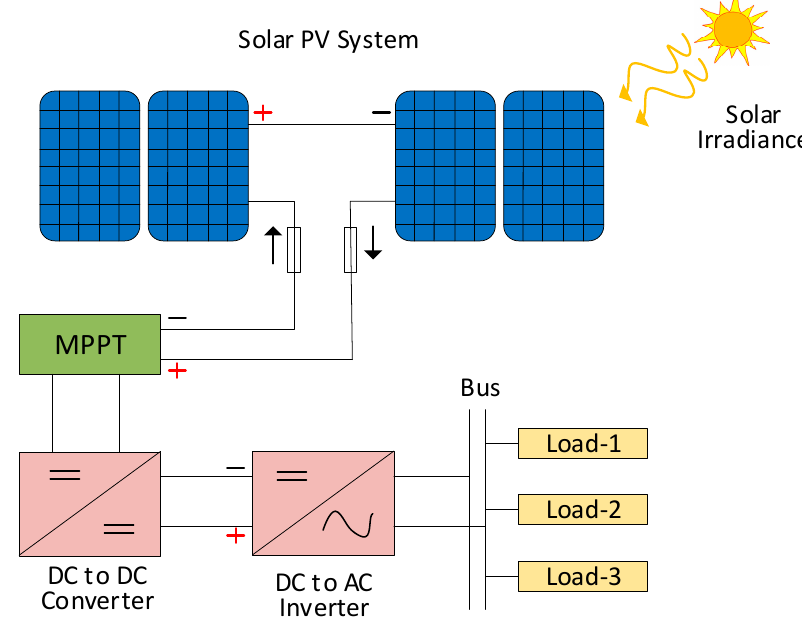
Figure 1. Solar photovoltaic (PV) system with maximum power point tracking (MPPT).